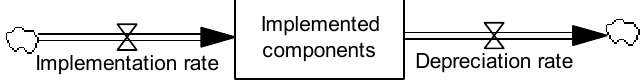
Figure 1. Basic stock and flow structure of implemented components.